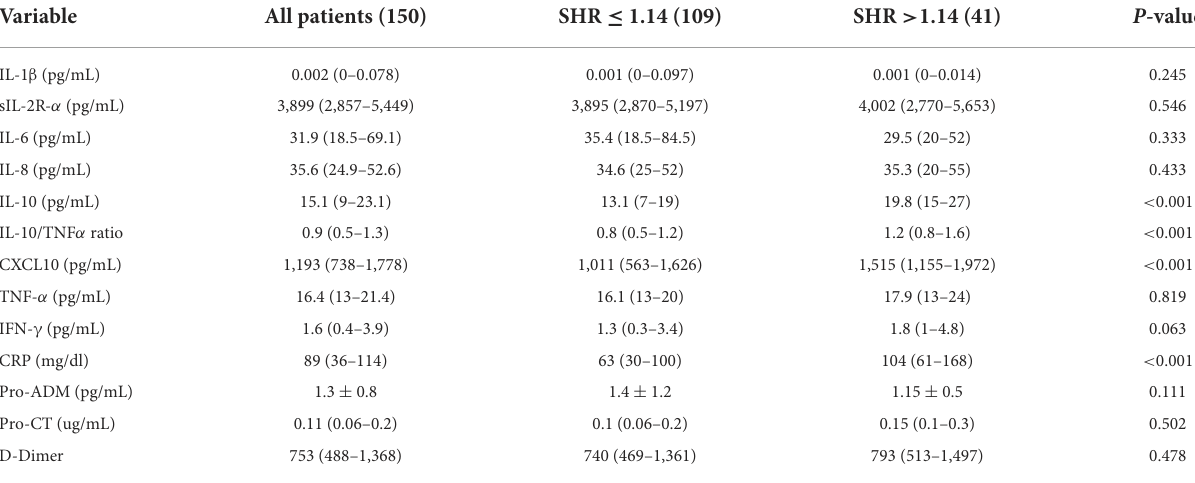
TABLE 2 Plasma levels of cytokines and chemokines in patients hospitalized with COVID-19 infection who were grouped according to a Stress Hyperglicemia Ratio (SHR) ≤ 1.14 or > 1.14.